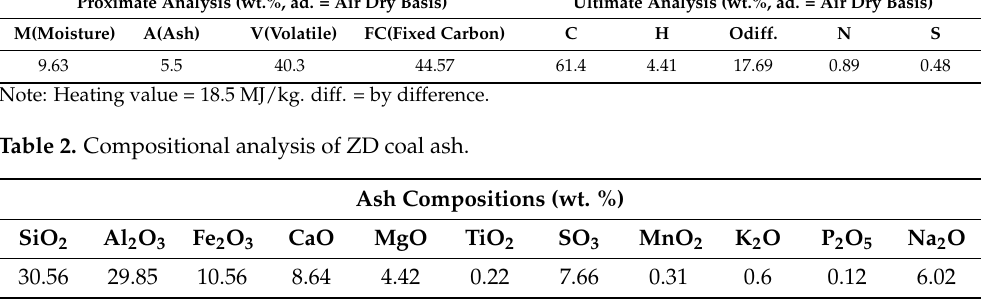
Table 1. Proximate and ultimate analysis of ZD coal. Proximate Analysis (wt.%, ad. = Air Dry Basis) Ultimate Analysis (wt.%, ad. = Air Dry Basis)